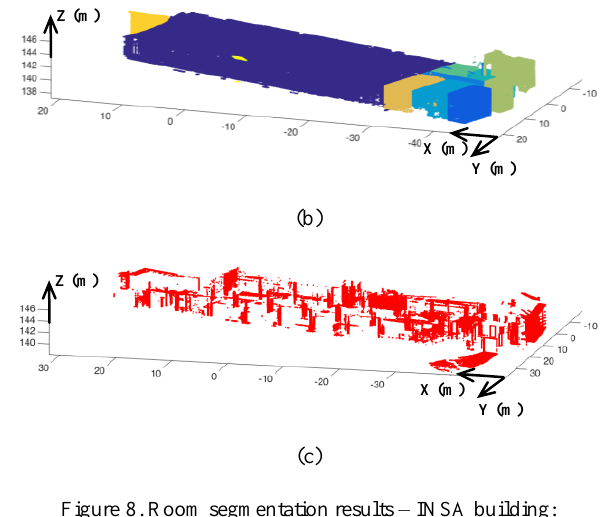
Figure 8. Room segmentation results – INSA building: (a) 2D regions and zoom in ceiling occluded by pillars; (b) 3D regions; (c) unattributed